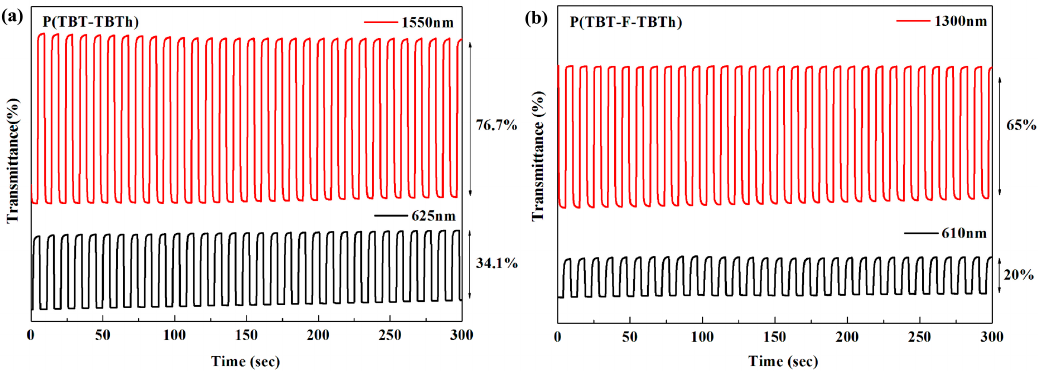
Figure 8. Electrochromic switching of the polymer films: (a) P(TBT-TBTh); (b) P(TBT-F-TBTh).